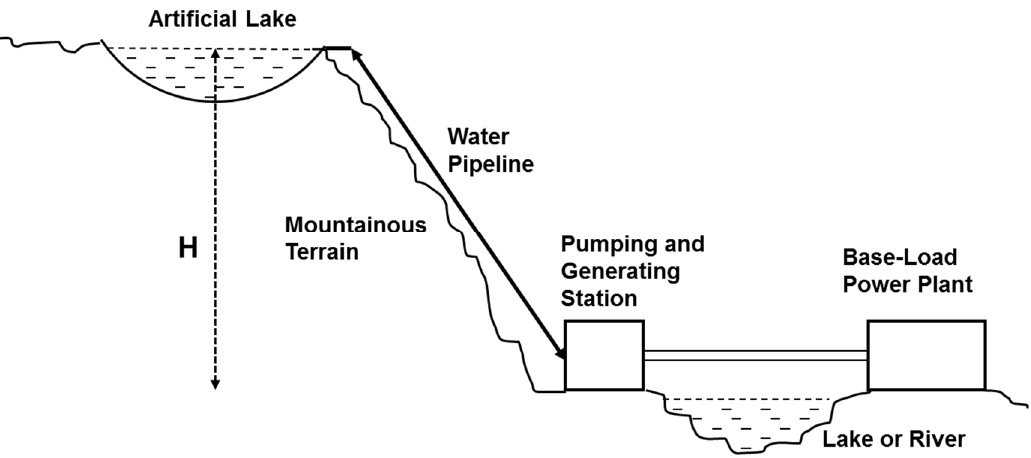
Figure 3. Schematic representation of a PHS .